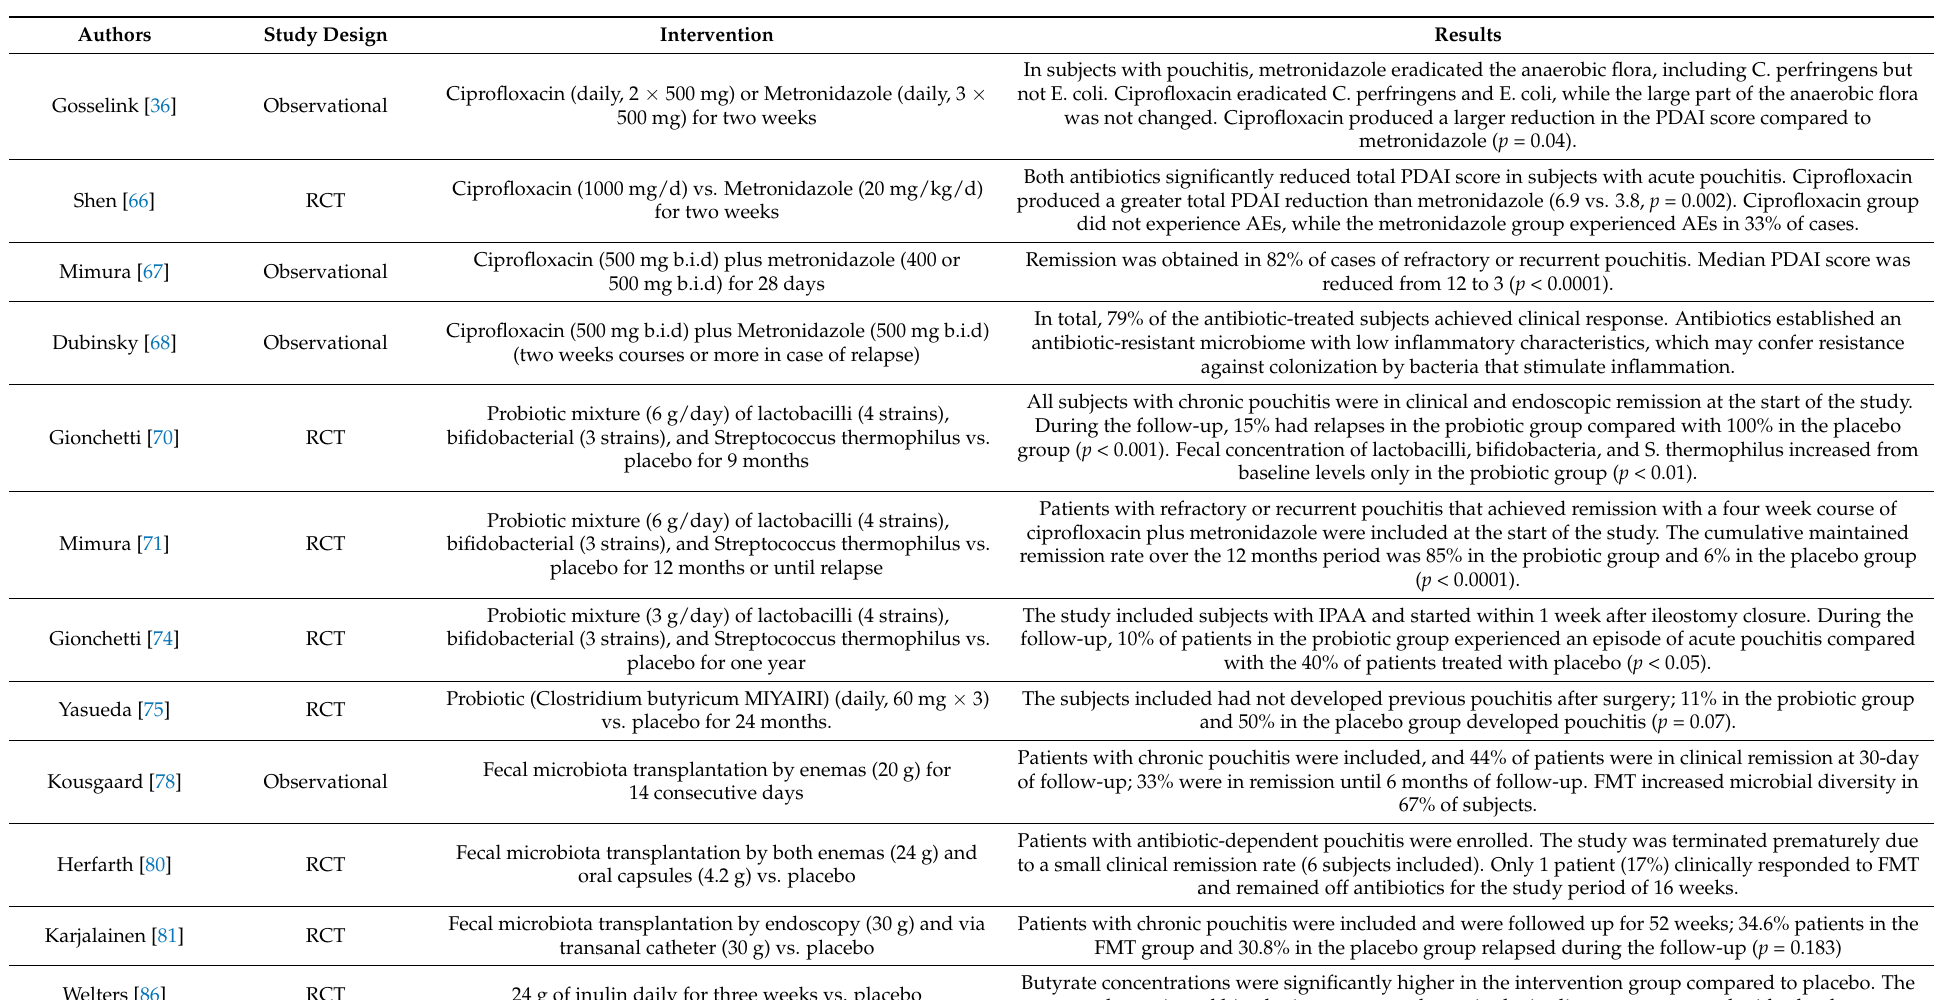
Table 3. Studies evaluating the interventions on the microbiota as a therapeutic target of